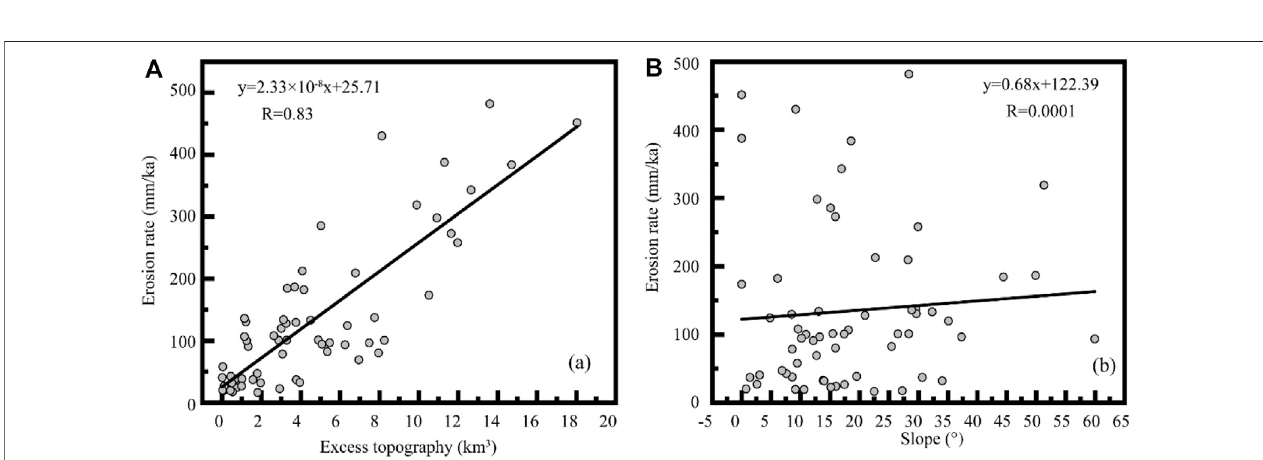
FIGURE5|(A) Correlationbetweentheerosionrateandtheexcesstopographyvolumeinthestudyarea. (B) Correlationbetweentheerosionrateandtheslopein the study area.